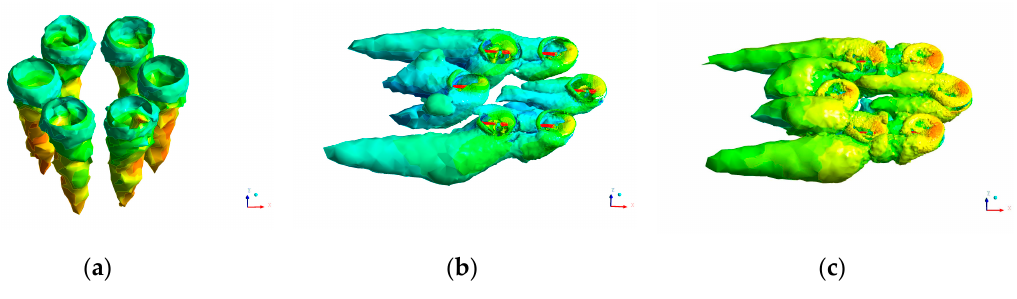
Figure 13. Vortex distribution of Hex-rotor UAV ( a ) 0 m/s ( b ) 2.5 m/s ( c ) 4 m/s.